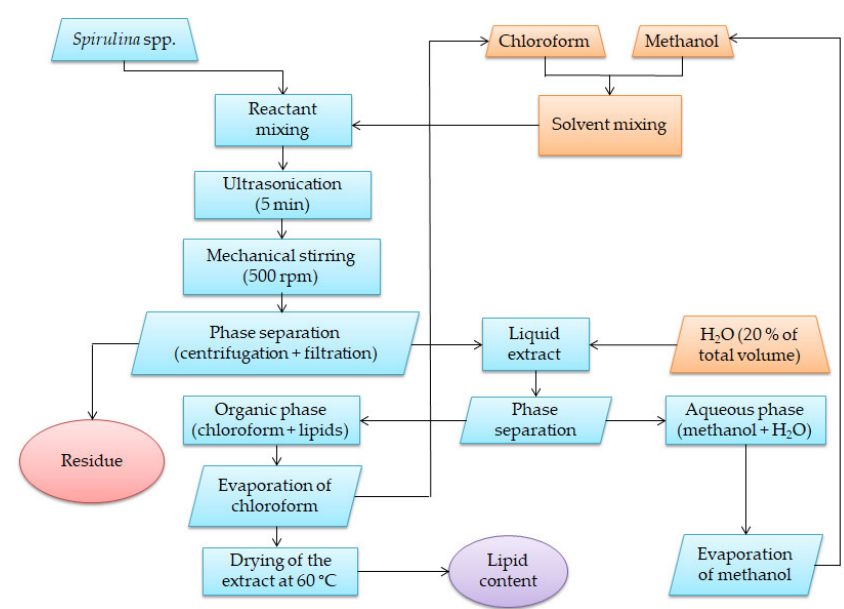
Figure 2. Schematic representation of lipid extraction from Spirulina spp.